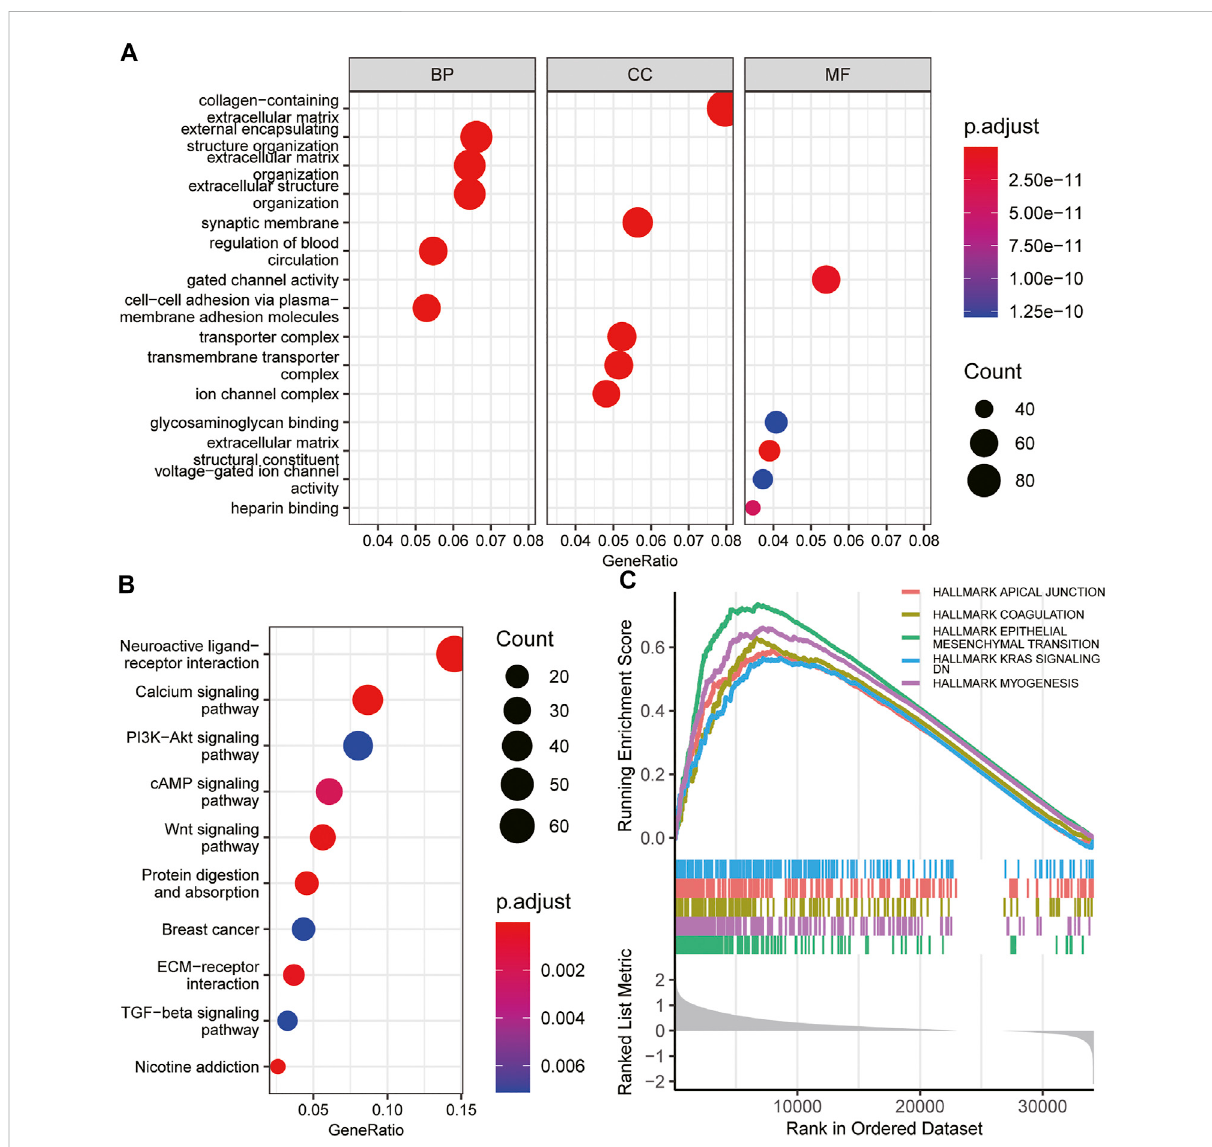
FIGURE 6 Functional enrichment of INHBB in GC. (A) GO enrichment analysis of INHBB in GC, (B) KEGG pathway analysis of INHBB in GC, and (C) GSEA enrichment analysis of INHBB in